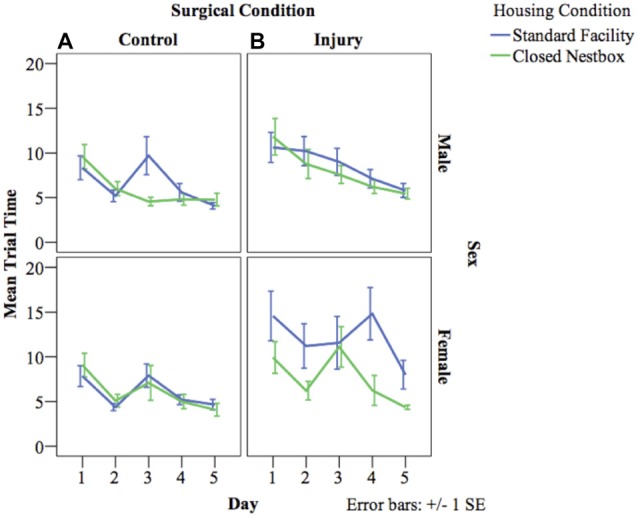
(A,B) Mean latency by surgical and housing condition in hidden platform (HP) testing for males and females. The following graphs mark the average latency of animals to reach the HP over the course of the four trials each day for five consecutive days. The lines compare average latency for animals in the CN and SF housing conditions according to surgical condition: (A) Control, (B) HI Injury. There were significant differences between surgical conditions regardless of housing condition for males (F(1) = 11.35 p < 0.001; HI males relative to Control males). Females demonstrated a significant interaction effect between surgical condition and housing condition (F(1) = 9.37 p < 0.001; HI SF as compared to all other groups, same sex), with HI SF females performing significantly worse than all other groups.